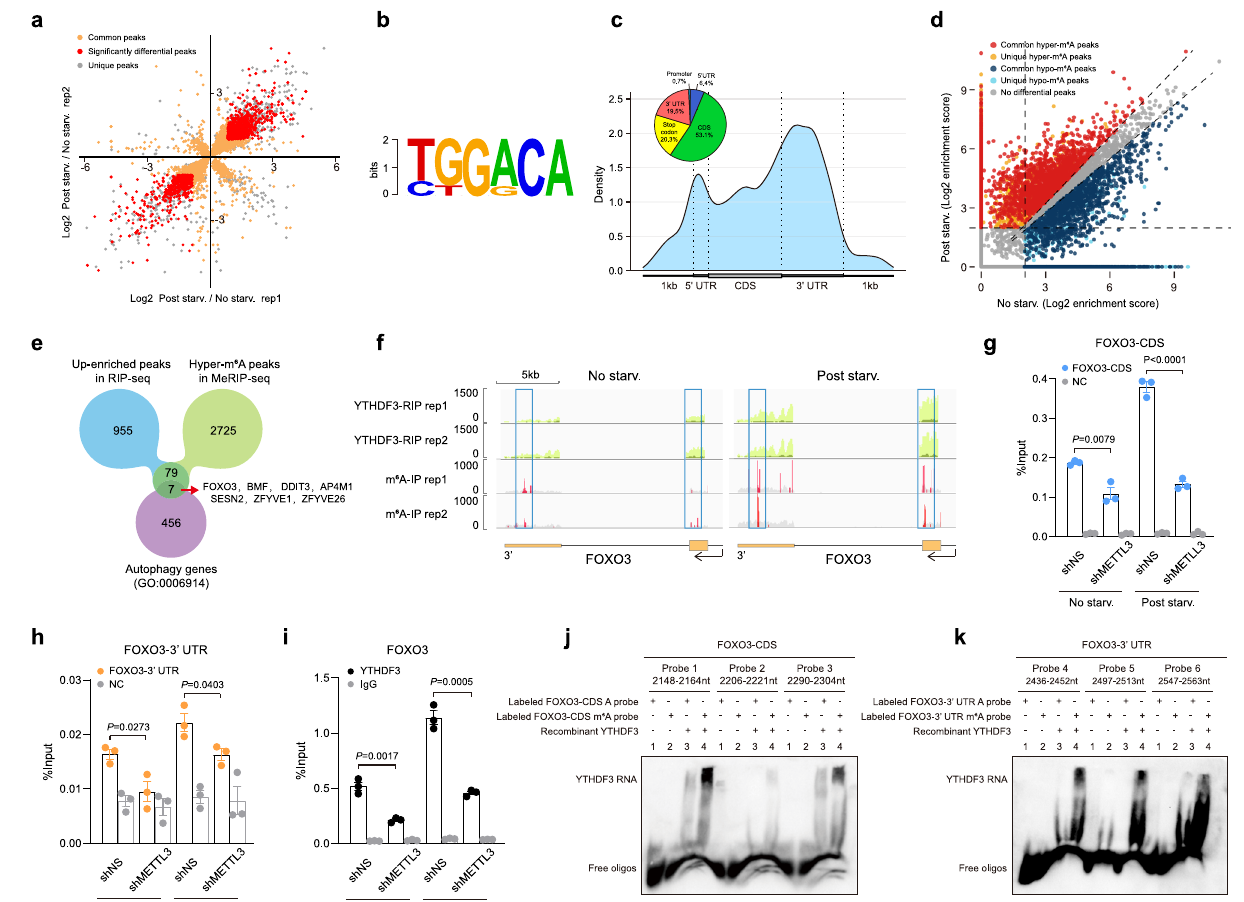
Fig. 5 | YTHDF3 recognizes starvation-induced m 6 A hypermethylation of FOXO3mRNA.a Thescatterplotdepictsfoldchanges(log2)ofYTHDF3-RIPtarget peaks in MEFs after nutrient deprivation. Red dots indicate signi fi cantly up- enriched and down-enriched peaks with a cutoff fold change of 1.8. b The con- sensussequencemotifidenti fi edwithinsigni fi cantdifferentiallyenrichedYTHDF3- binding sites, determined by the HOMER database. c Metagene pro fi les of the signi fi cant differentially enriched YTHDF3-binding sites along a normalized tran- script, consisting of three rescaled non-overlapping segments: 5 ’ UTR, CDS, and 3 ’ UTR. Pie chart depicting the fraction of signi fi cant differentially enriched YTHDF3-binding sitesindifferent transcript segments. d Scatterplotshowing m 6 A peaks with increased (red) or decreased (blue) levels in response to nutrient de fi - ciency. e Venn diagram showing the number of overlapping up-enriched YTHDF3- binding targets and hyper-m 6 A-methylated mRNAs upon nutrient deprivation. Then theresultant 86 peakswereannotated to GO termautophagy(0006914)and